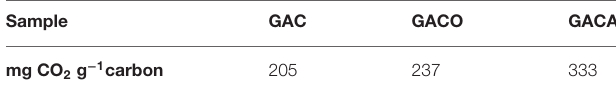
TABLE 6 | CO 2 adsorption capacity (mgCO 2 g − 1 ) at 273K and 1 bar for the